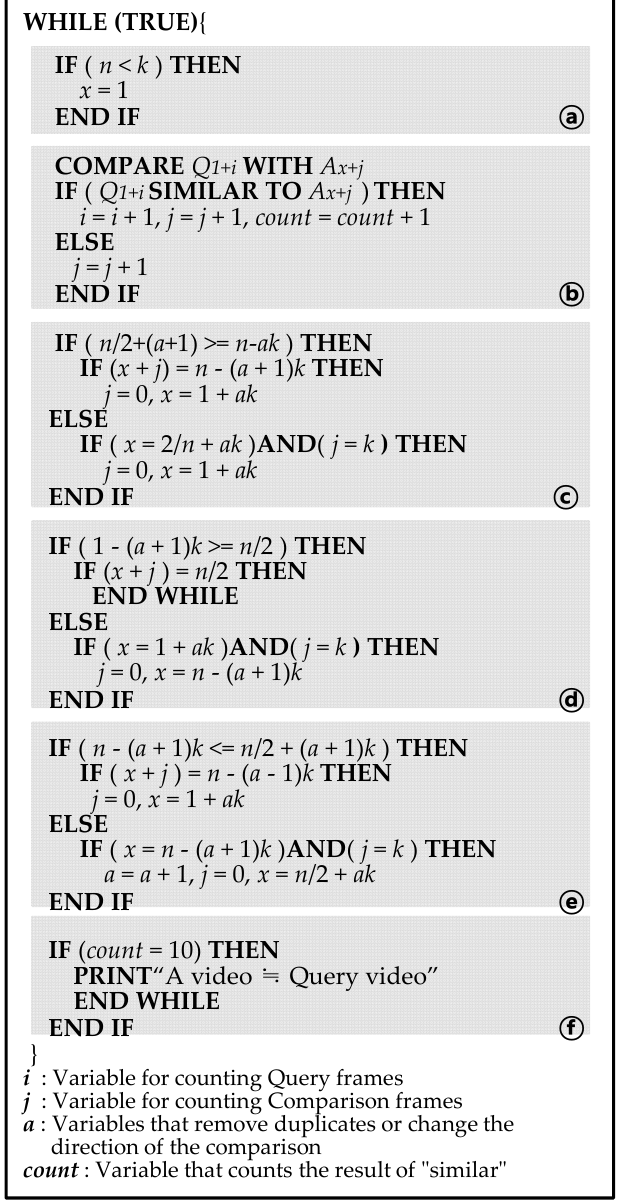
Figure 3. Pseudocode used for comparison.